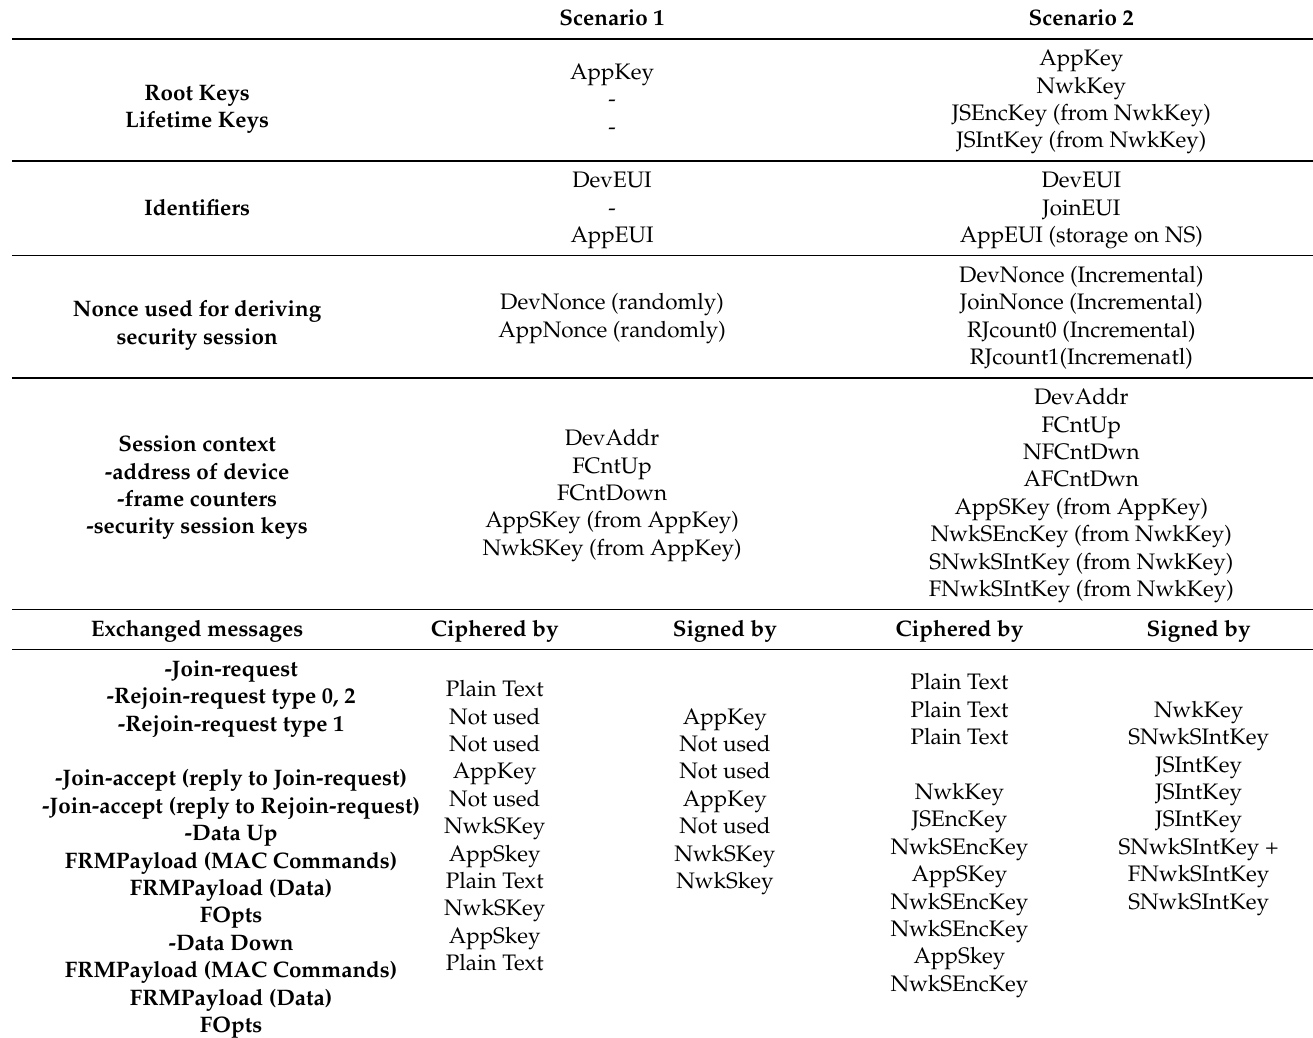
Table 2. A comparison between scenarios 1 and